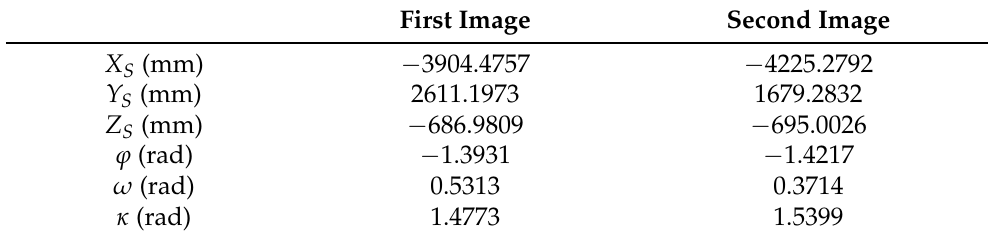
Table 9. The elements of exterior orientation of the two images in second experiment.